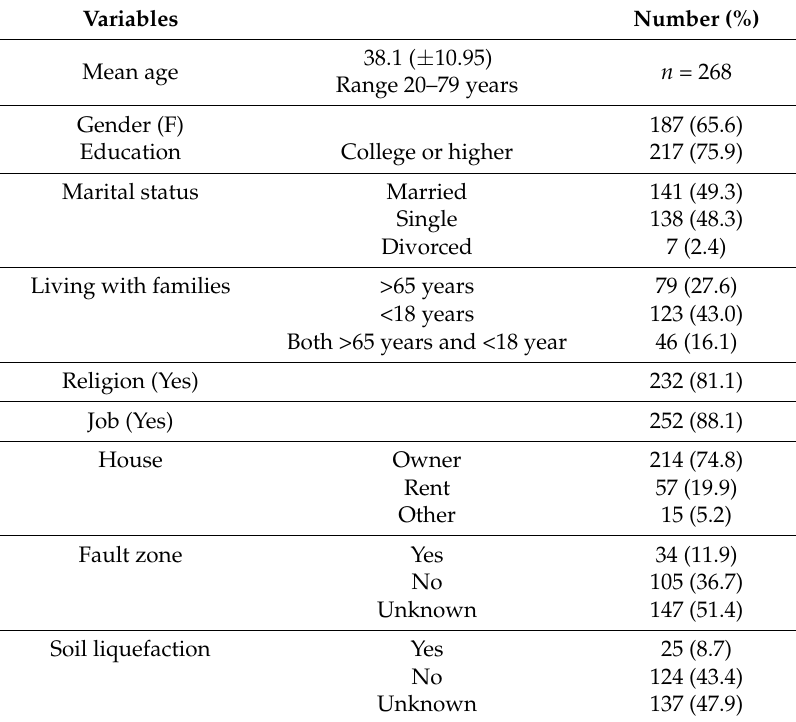
Table 1. Participants’ demographic characteristics ( n =